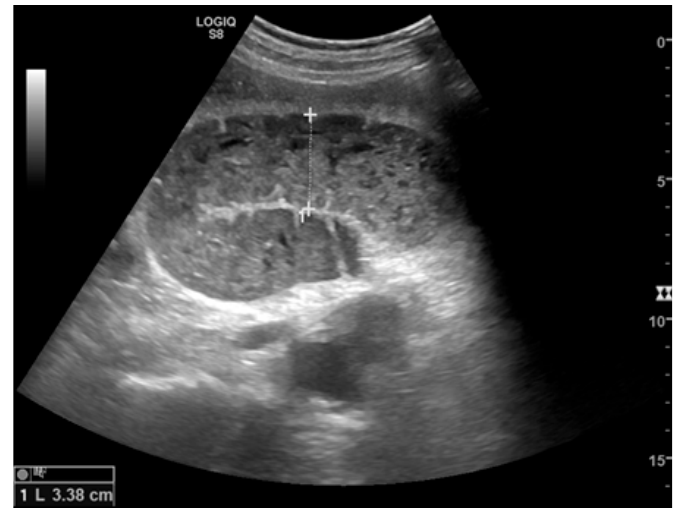
artifacts are visible due to air ‐ fluid levels (dashed arrow) ( b ) and groups of bowel loops with se ‐ vere differences in diameter ( ʹ bowel jump diameter’) are evident more superficially (*) ( b ). No free fluid was detected in the abdominal cavity or between bowel loops.